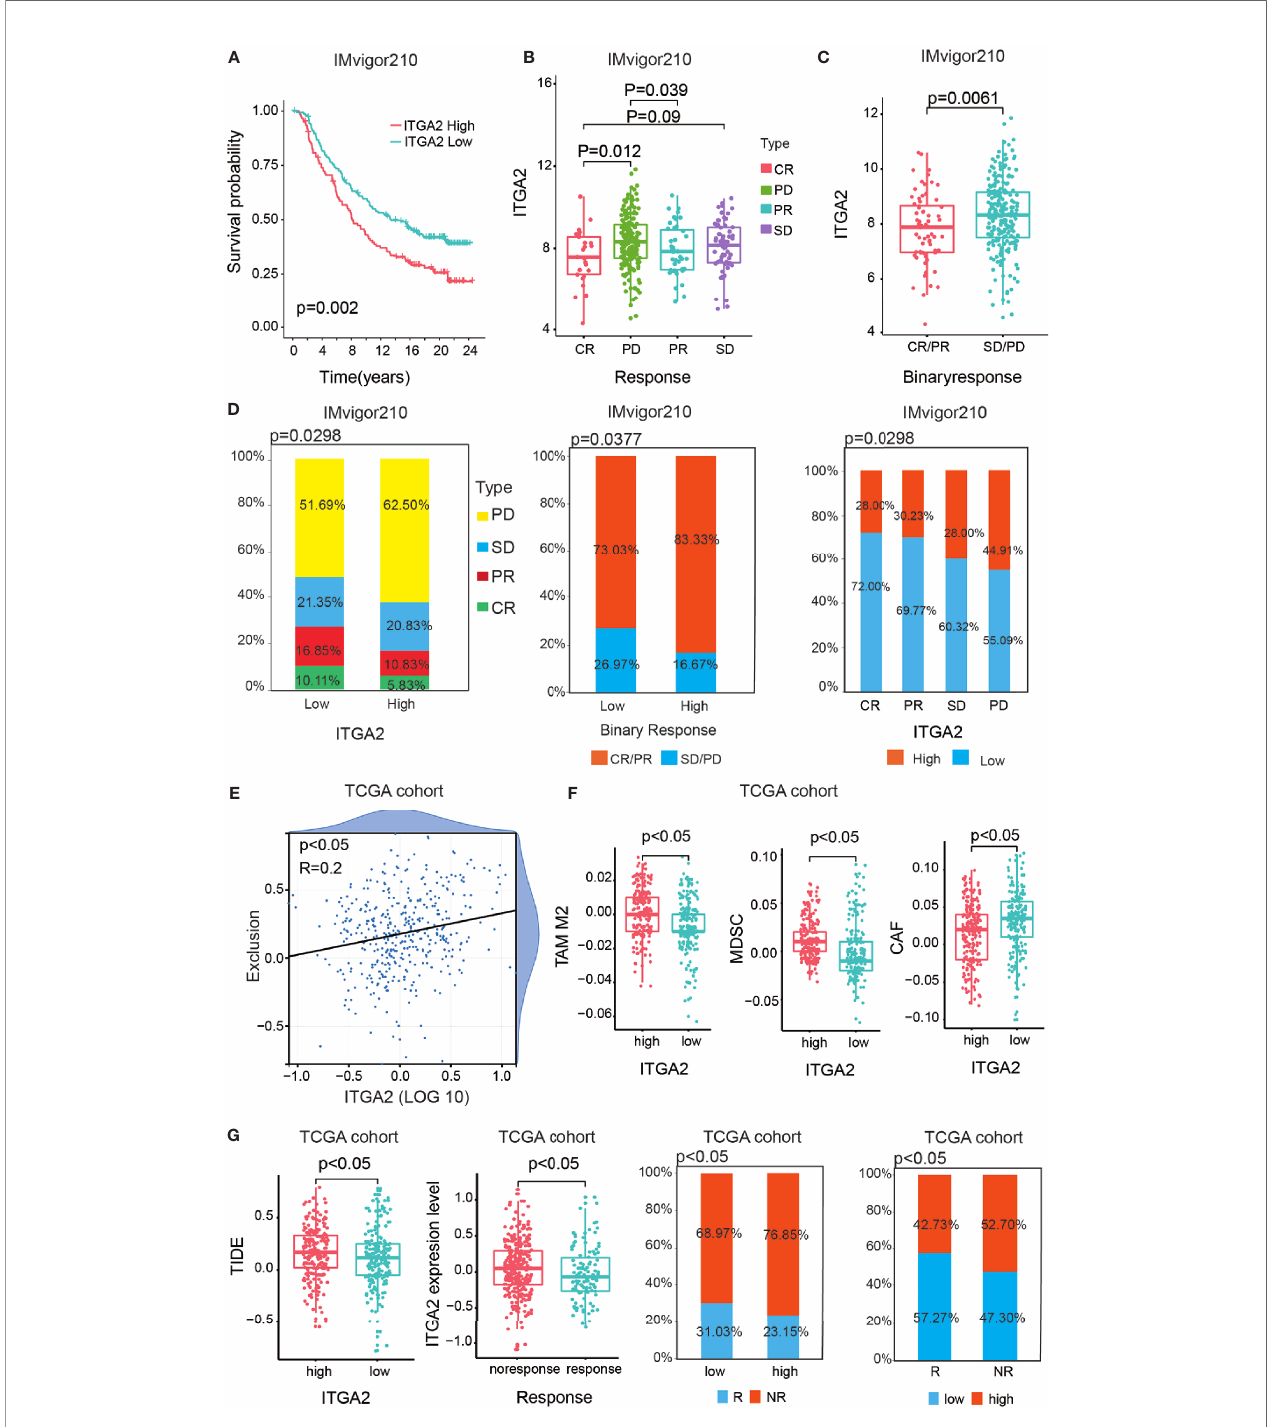
FIGURE 8 | The statistics analysis of ITGA2 in the anti-PD-L1 (IMvigor210) cohort. (A) Kaplan – Meier overall survival (OS) curves of patients regarding the response of anti-PD-L1 (IMvigor210) cohort grouped by integrin alpha-2 (ITGA2) expression. (B) The variance analysis of ITGA2 in the distinct anti-PD-L1 clinical response groups. (C) The variance analysis of ITGA2 in the binary response. (D) The proportion analysis between ITGA2 subgroups and the distinct anti-PD-L1 clinical response groups. Chi-square test was used for data analysis. (E) The correlation analysis between ITGA2 expression level and the abundance of T cell exclusion. (F) The variance analysis of the TAM M2, MDSC, and CAF cells in the low- and high-ITGA2 groups. (G) The variance analysis of ITGA2 in the clinical responses and the variance analysis between ITGA2 subgroups and TIED score. The proportion analysis between clinical response groups and ITGA2 subgroups. Chi-square test was used for data